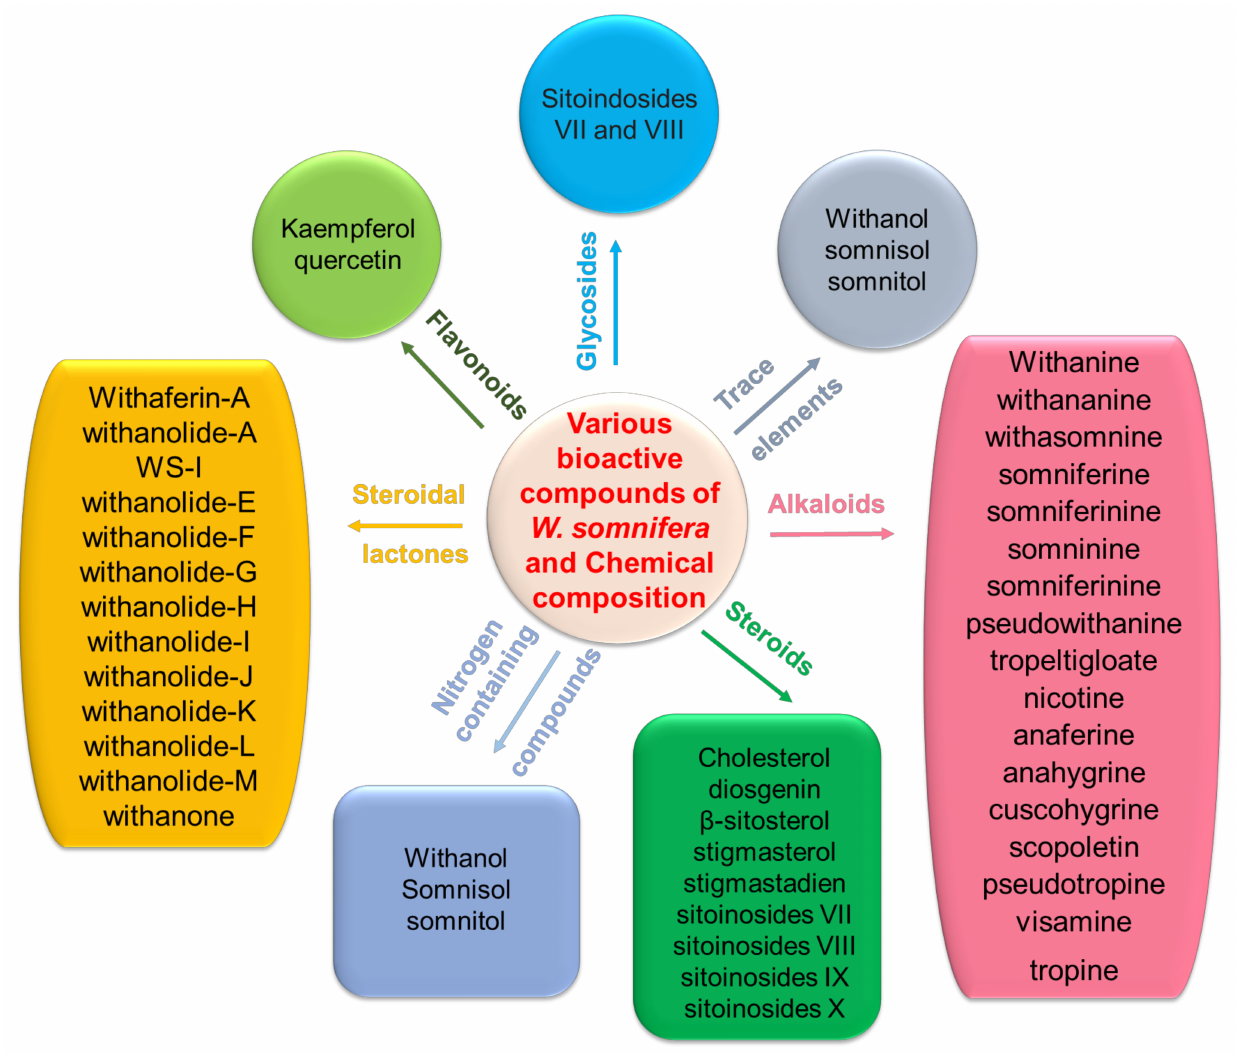
Figure 1. Various phytochemicals present in Withania somnifera